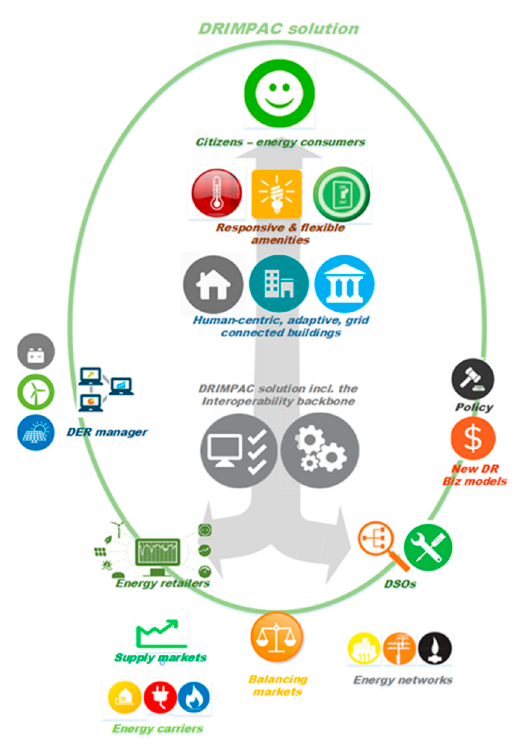
Figure 1. The DRIMPAC solution